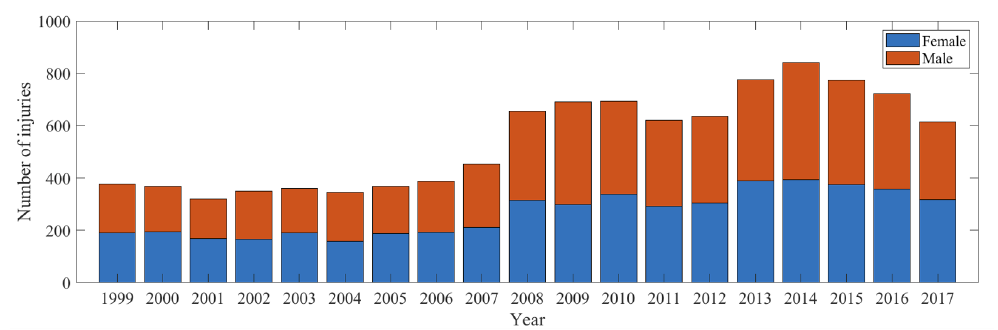
Figure 1. Number of injuries by sex between 1999 and